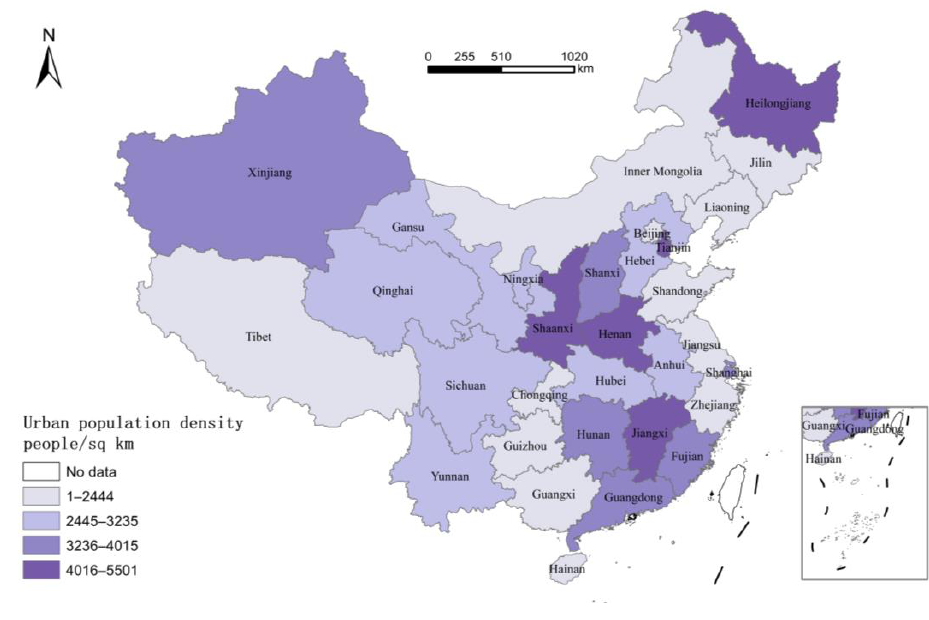
Figure 3. Urban Population Density by Province in 2020.